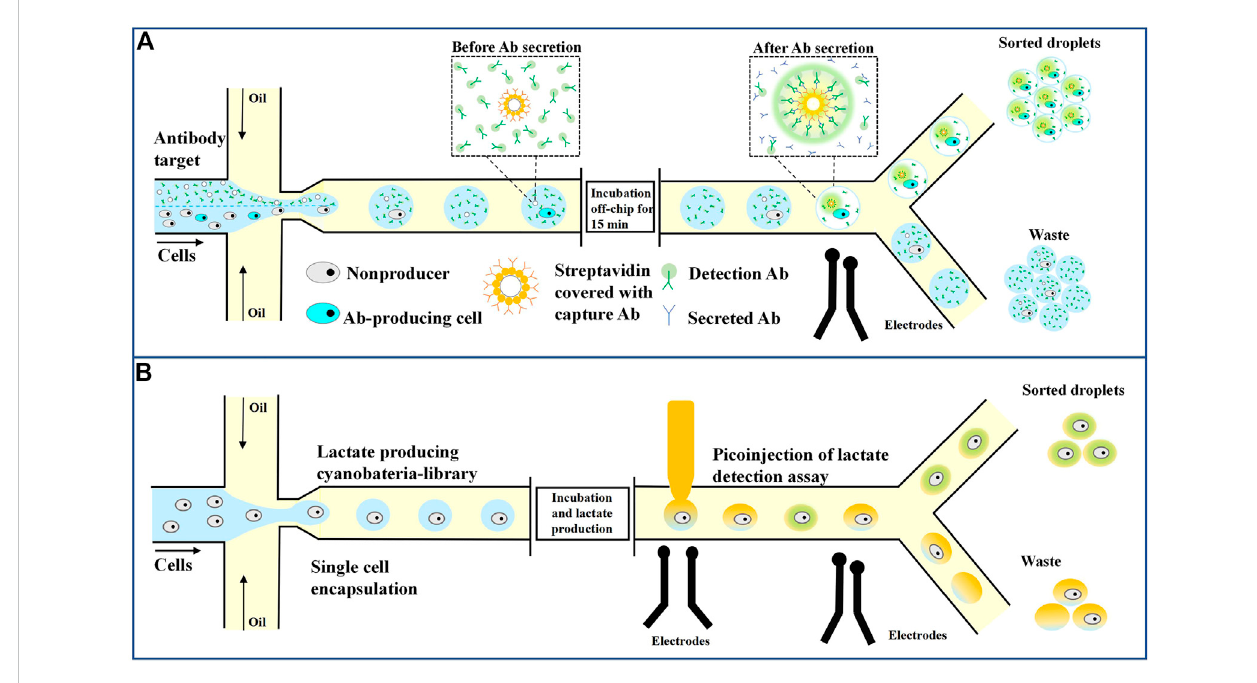
FIGURE 5 Droplet micro fl uidics for single-cell screening. (A) Sorting of antibody-secreting cells. Secreted antibodies were captured on the bead with fl uorescently labeled detection antibodies, leading to the localization of fl uorescent signals on the bead, and fl uorescent droplets can then be sorted (Mazutis et al., 2013). (B) Lactate-producing cyanobacteria are encapsulated as single cells in 10 pL droplets. Following lactate production through incubation,anassayisperformedwherethedropletsareinjectedwithanenzymethatcatalyzestheactivationofa fl uorescentdyeinthepresenceof lactate. The fl uorescent droplets are analyzed and sorted based on the strength of the signal (Hammar et al.,